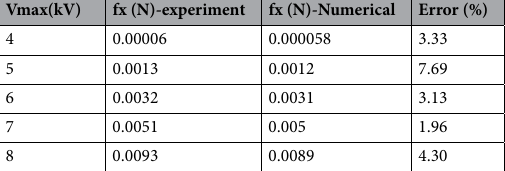
Table 4. The comparison of the calculated integrated horizontal body force component for different input voltages and the experimental results.